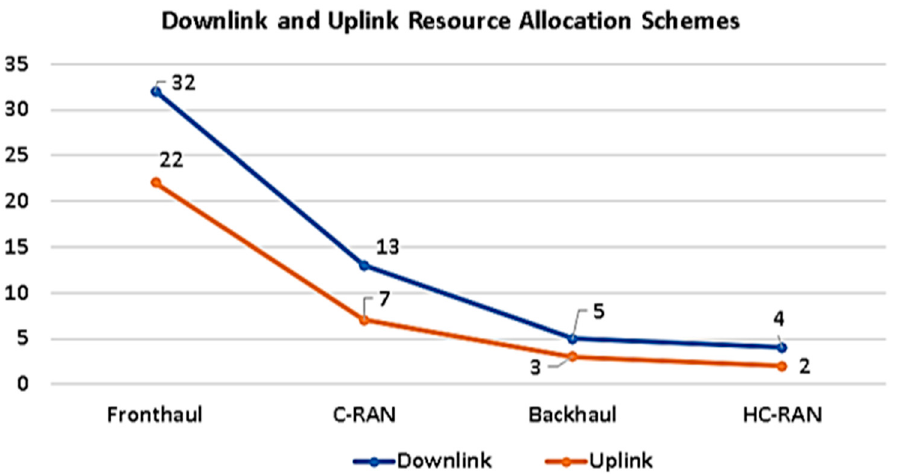
Figure 10. Articles studied for downlink and uplink resource allocation